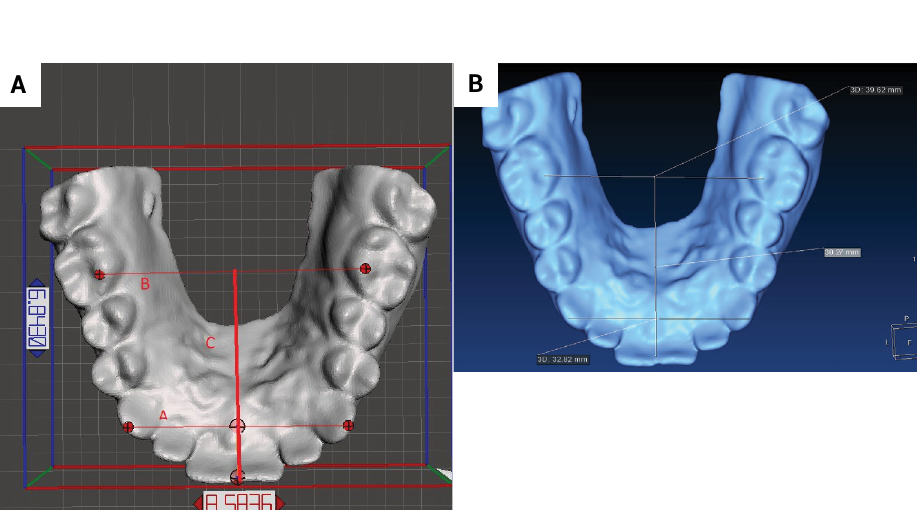
Figure 1. A - Meshmixer measurements GM. B - OrthoAnalyzer measurements SM1.